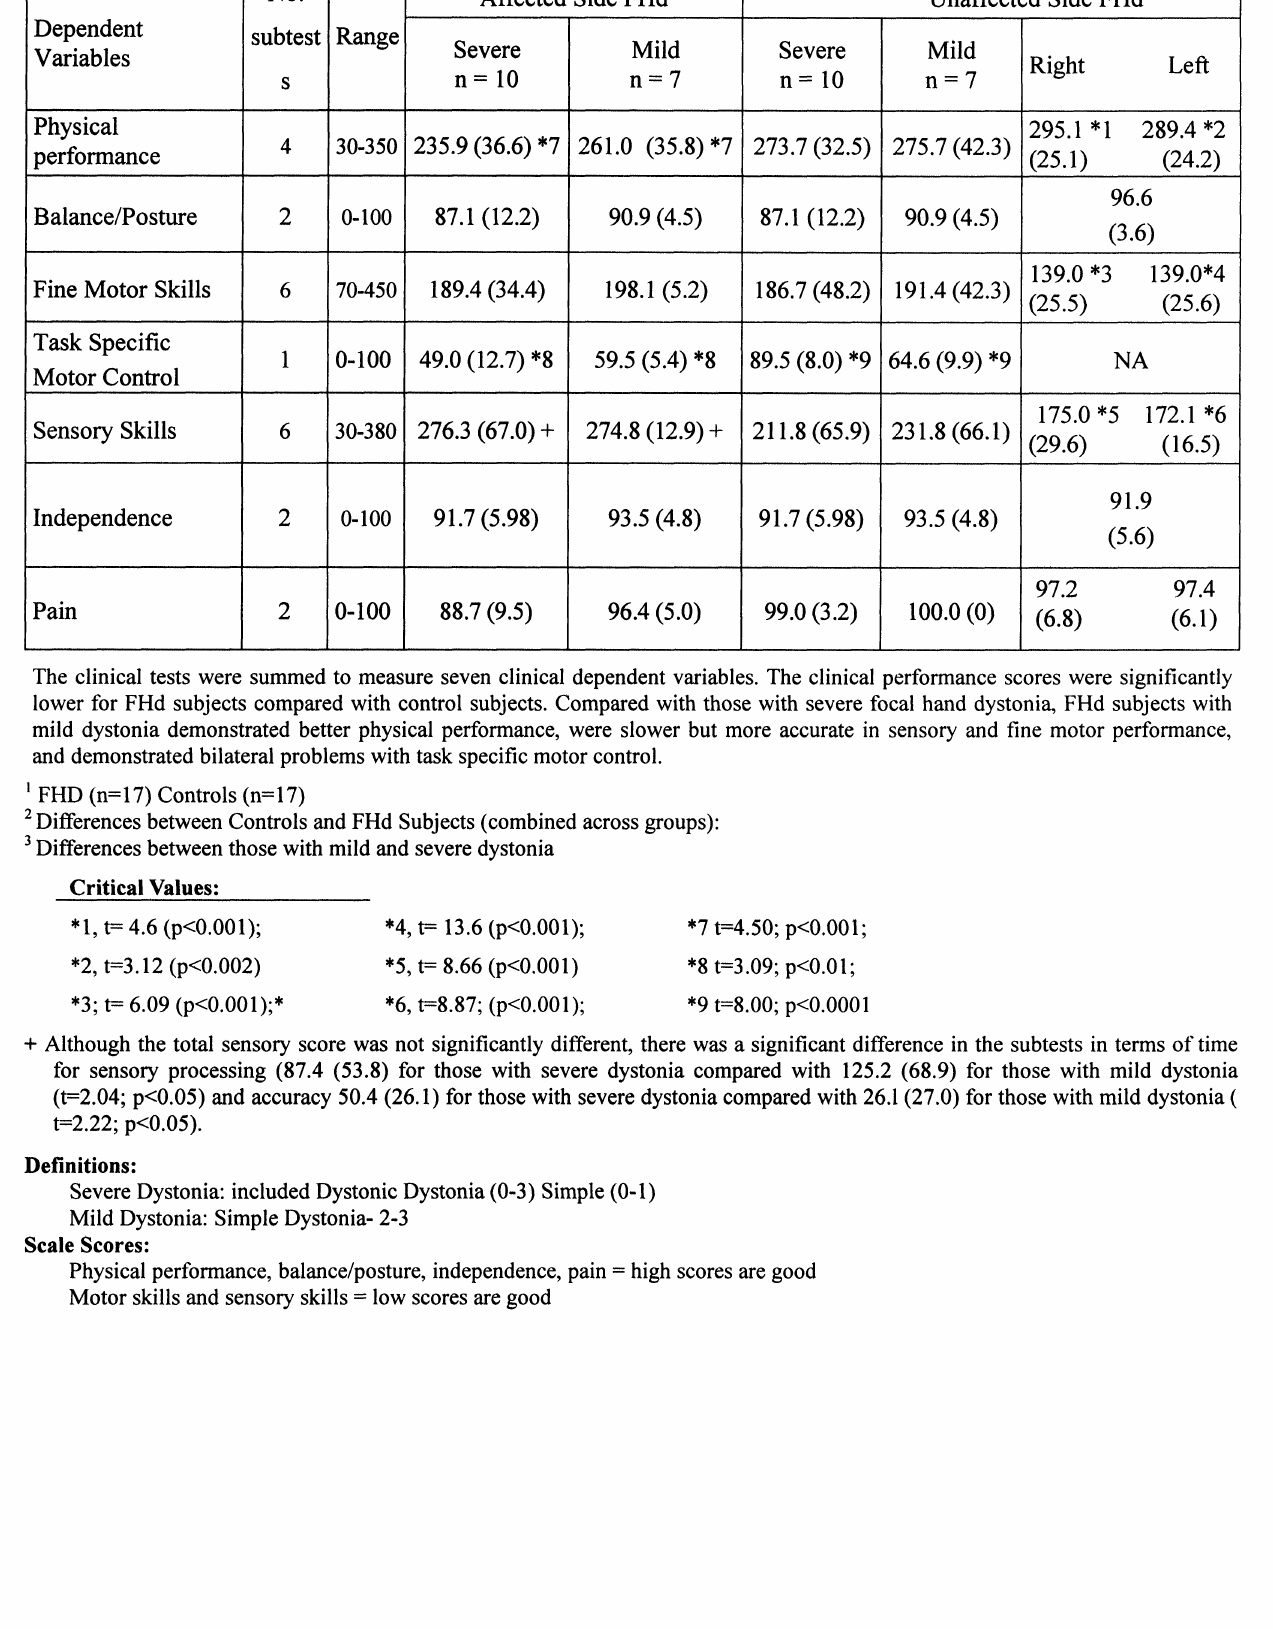
Clinical performance of controls and FHd subjects by severity of dystonia